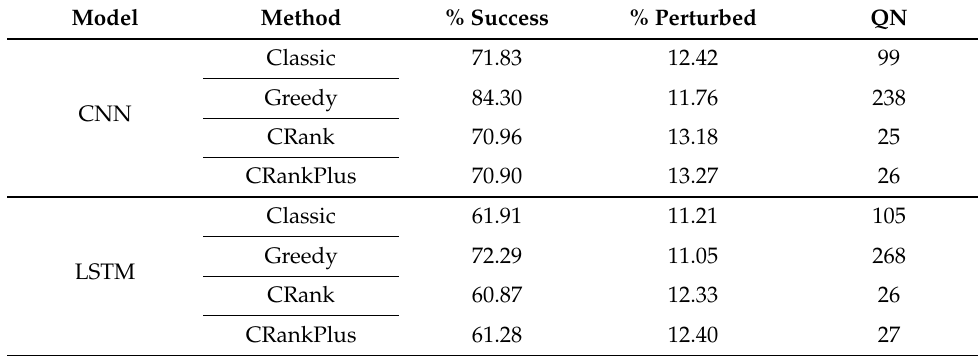
Table 9. Results of attacking various models. “QN” is query number.